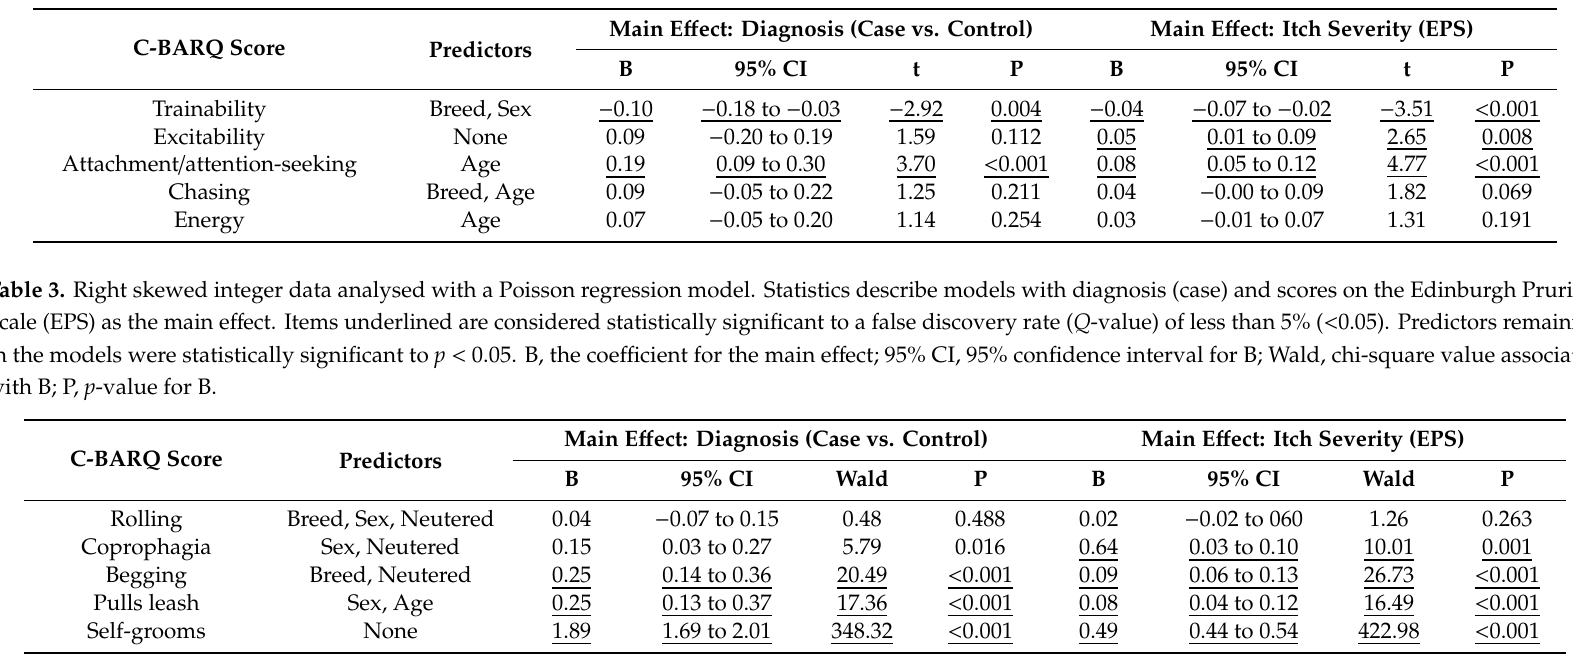
Table 2. Results of linear regression models comparing behaviour scores for Labrador and Golden Retrievers with a veterinary diagnosis of canine atopic dermatitis (cases) to Labrador and Golden Retrievers with no skin problems (controls), and to scores on the Edinburgh Pruritus Scale (EPS). Items underlined are considered statistically significant to a false discovery rate ( Q -value) of less than 5% ( < 0.05). Predictors remaining in the model were statistically significant to p < 0.05. B, the coe ffi cient for the main e ff ect; 95% CI, 95% confidence interval for B; t, the t-statistic (B divided by its standard error); P, p -value for B.